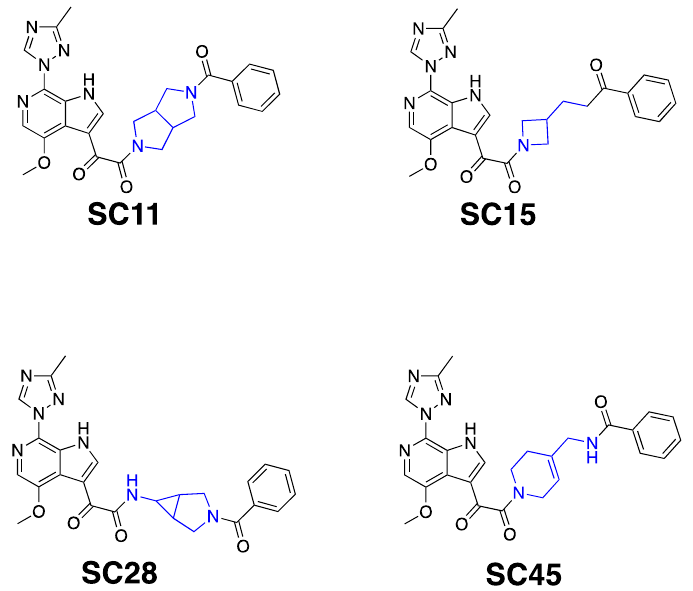
Figure 1. Chemical structures of compounds SC11 , SC15 , SC28 , and SC45 . The different core scaffolds in each compound are colored blue.